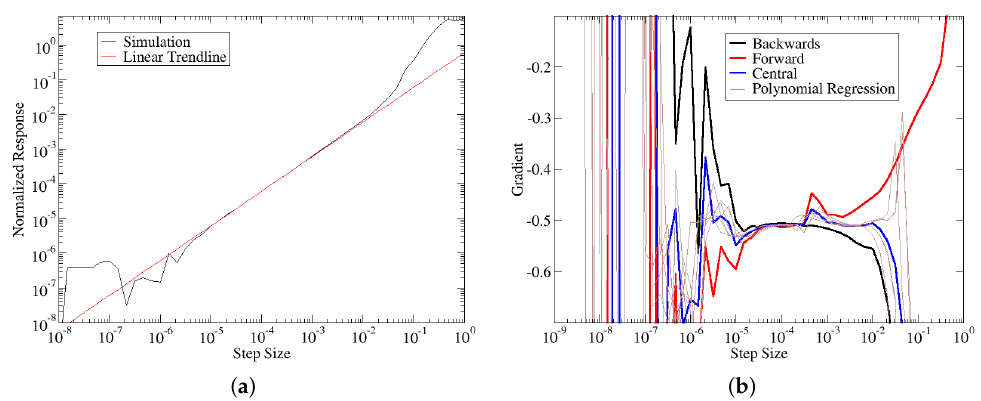
Figure 1. Comparison of the response to the numerical gradient. ( a ) Normalized blade failure constraint value vs. Spar-cap uniaxial laminate thickness. ( b ) Numerical gradient estimates of blade failure with respect to laminate thickness control point. The thin brown lines are additional gradient estimates based on polynomial regression which is explained in the